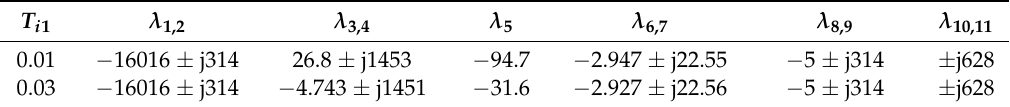
Table 4. Eigenvalues when T i 1 = 0.01 and T i 1 =